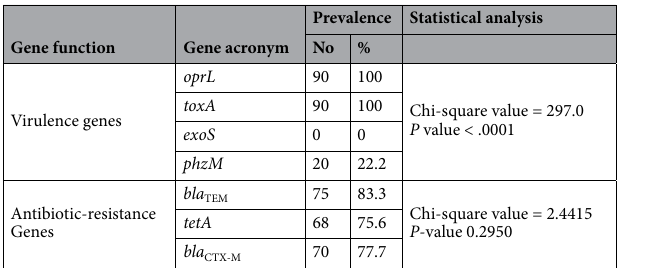
Table 5. The prevalence of virulence and antibiotic resistance genes among isolated P. aeruginosa strains from naturally infected O. niloticus and C. gariepinus